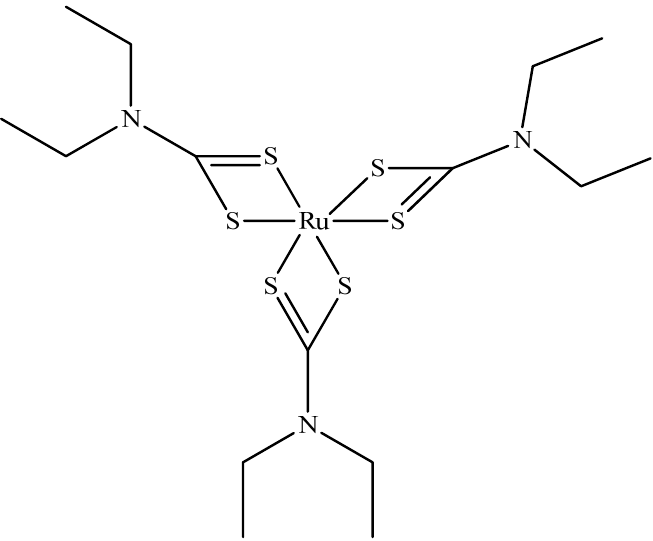
Figure 3. Tris(diethyldithiocarbamato)ruthenium(III) ([Ru(DDTC) 3 ]).